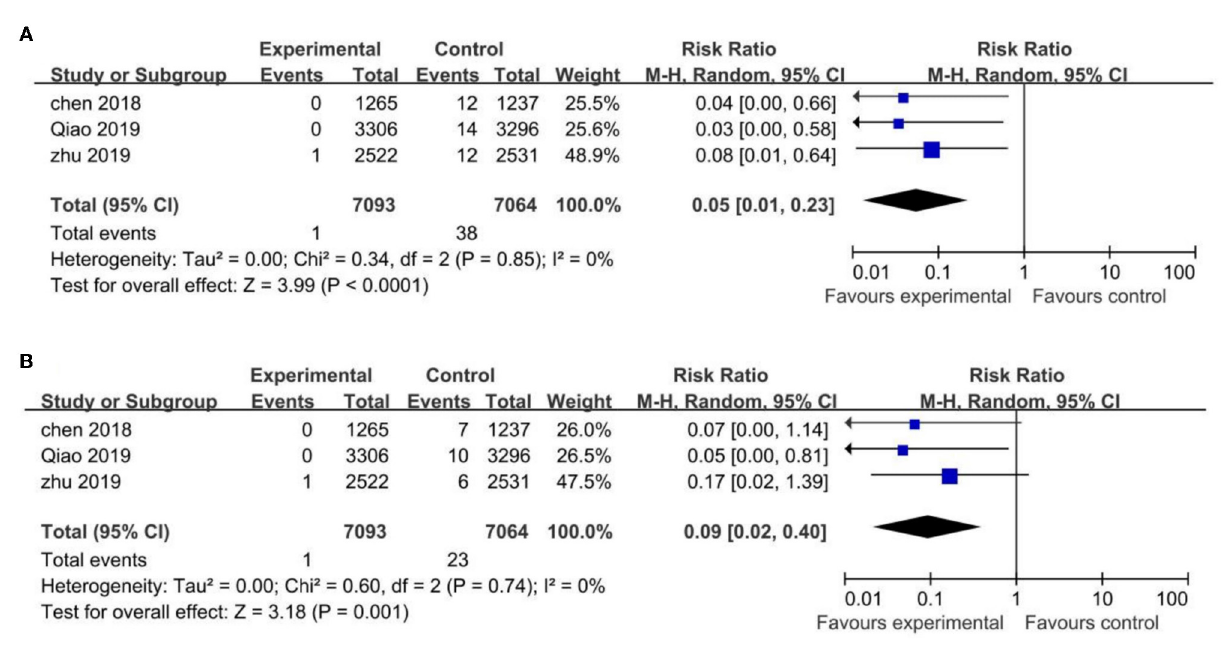
FIGURE4 The risk of CIN1 + (A) and CIN2 + (B) with HPV vaccination vs. control.